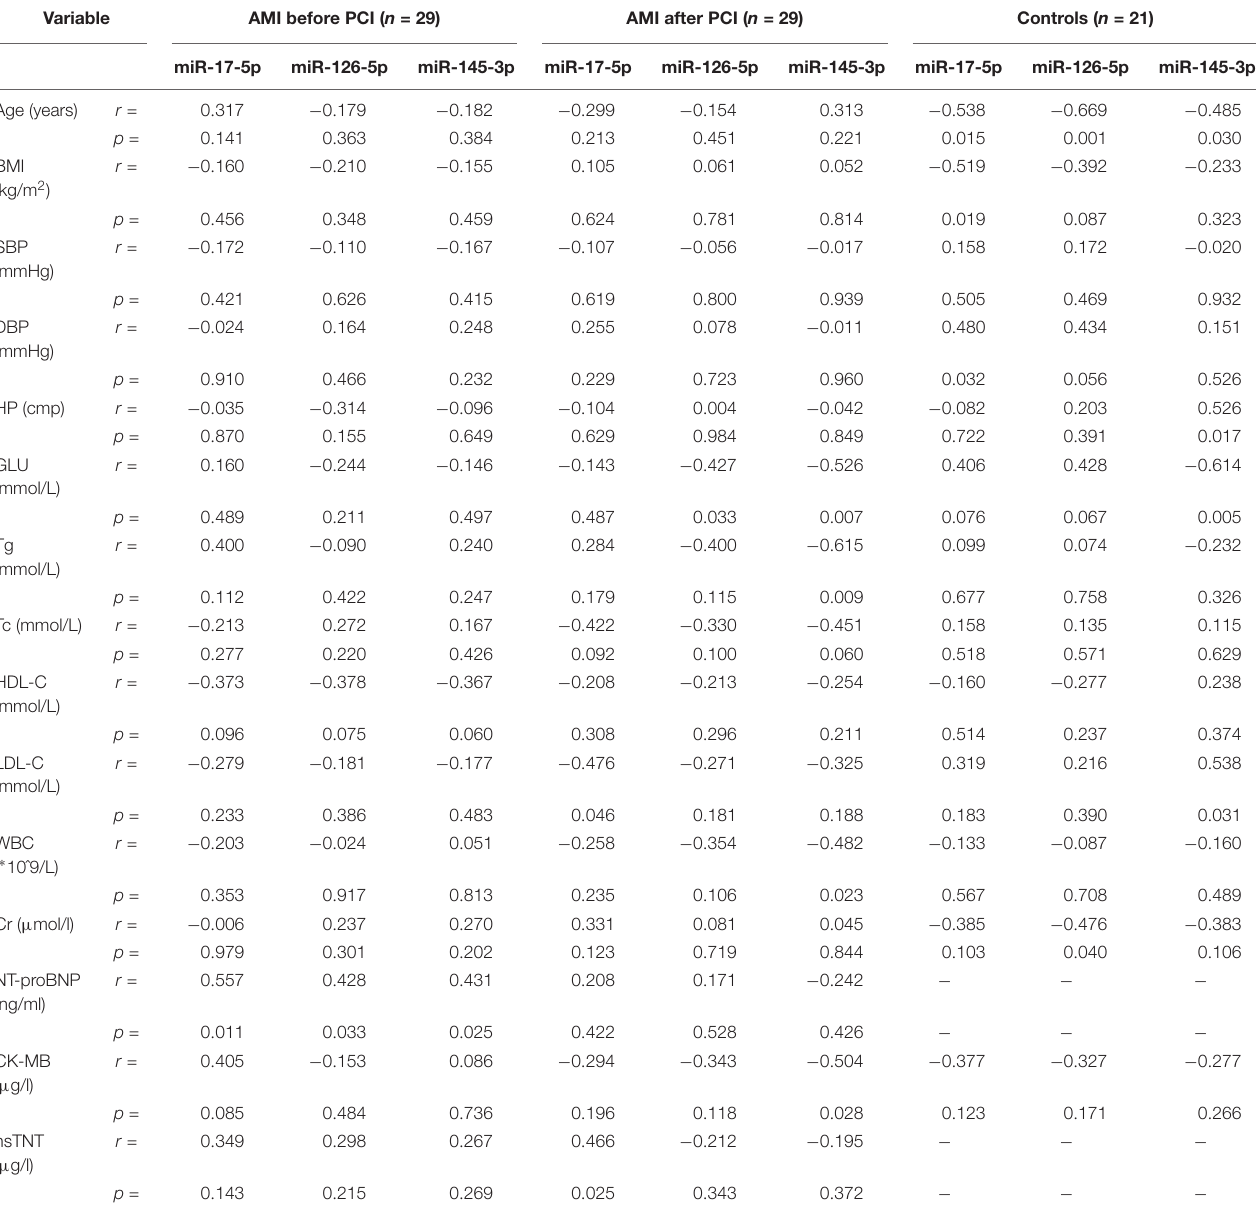
TABLE 2 | Relationships between miR-17-5p, miR-126-5p, miR-145-3p, and classical cardiovascular risk factors in patients with AMI and control subjects. Variable AMI before PCI ( n =